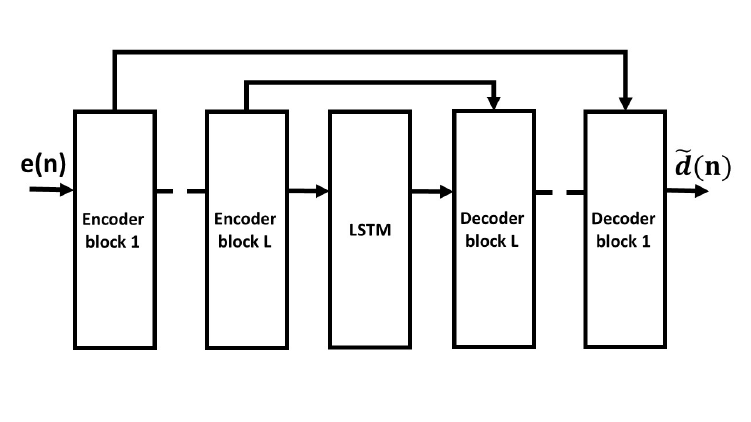
Figure 4. Structure of the speech-denoising model’s encoder and decoder blocks. Conv. stands for convolution, and Trans. stands for transpose.